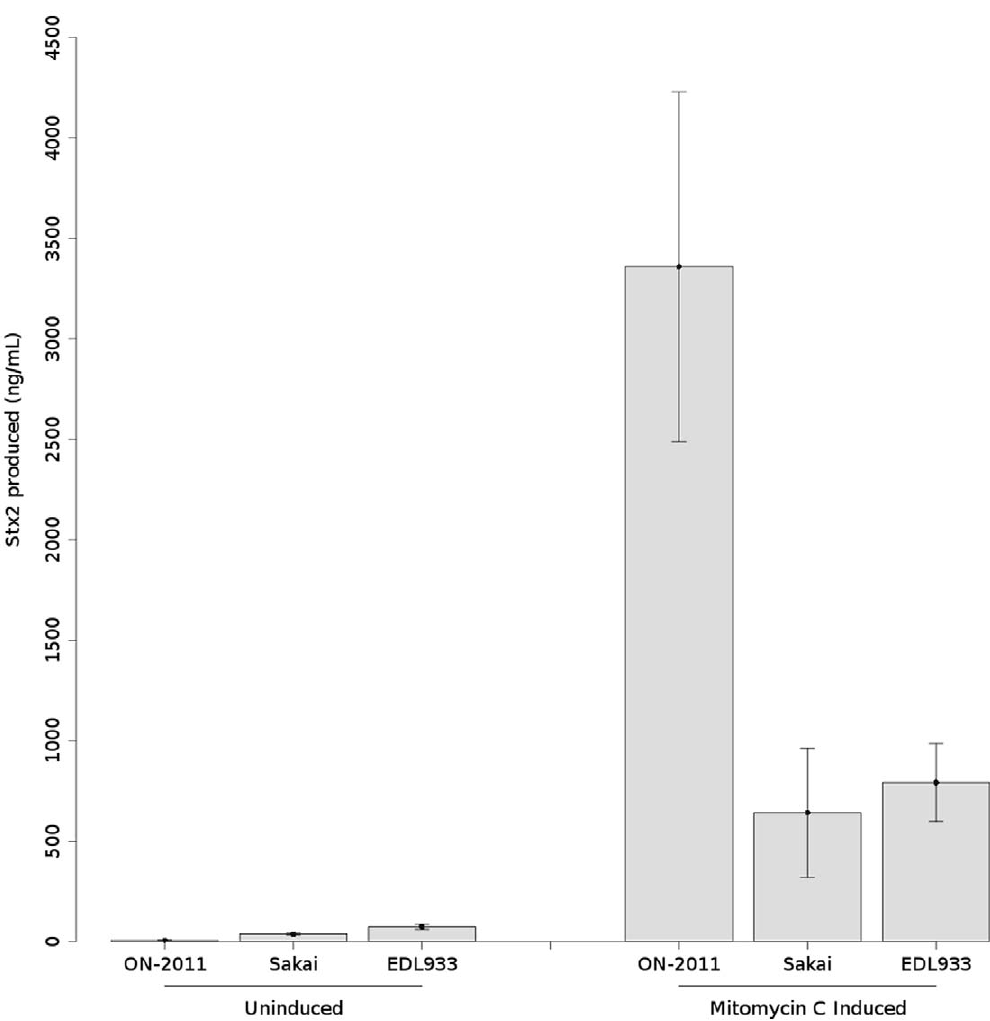
Figure 6. Stx2-production by E.coli O104:H4 outbreak-related strain ON-2011 and E.coli O157:H7 strains EDL933 and Sakai in un- induced, and mitomycin C-induced states as measured by a Stx2-specific ELISA. Error bars represent standard deviations from three independent replicates.